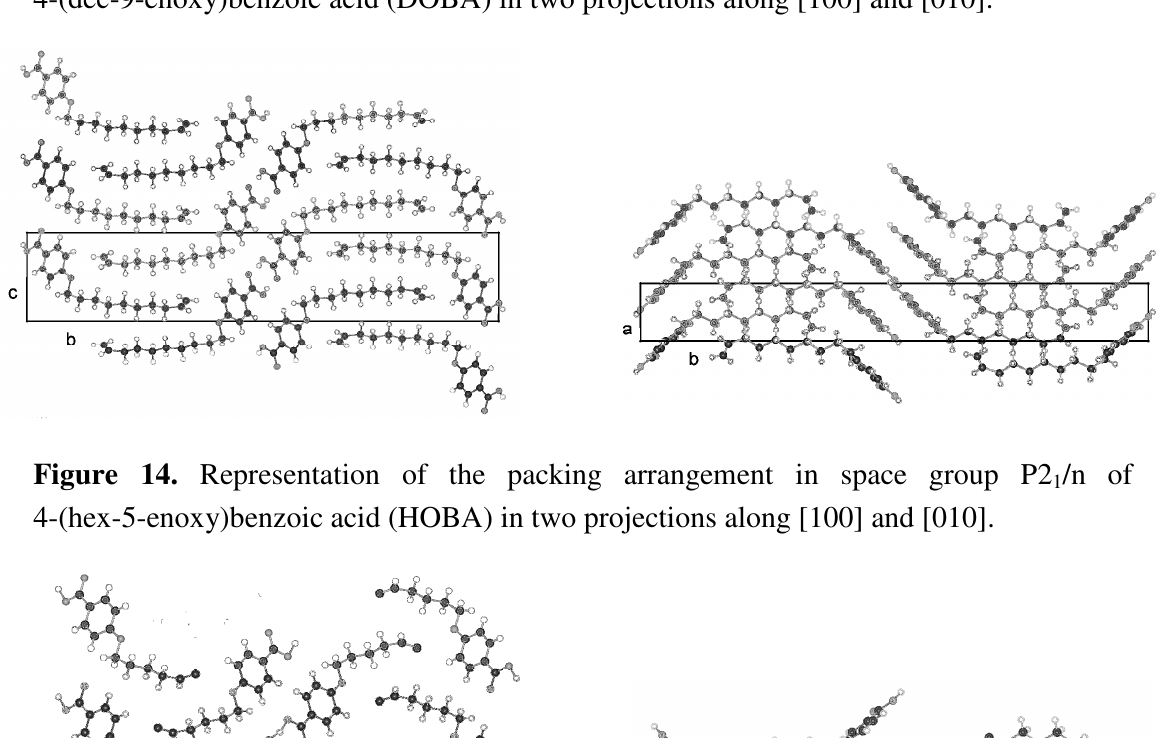
Figure 13. Representation of the packing arrangement in space group P2 4-(dec-9-enoxy)benzoic acid (DOBA) in two projections along [100] and [010].